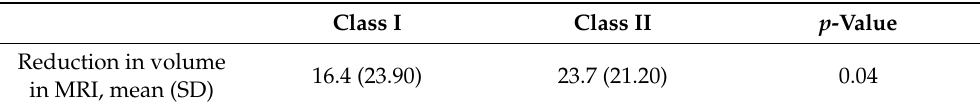
Table 3. Mean and range for the absolute reduction of the volume (ml) of venous malformations in MRI.